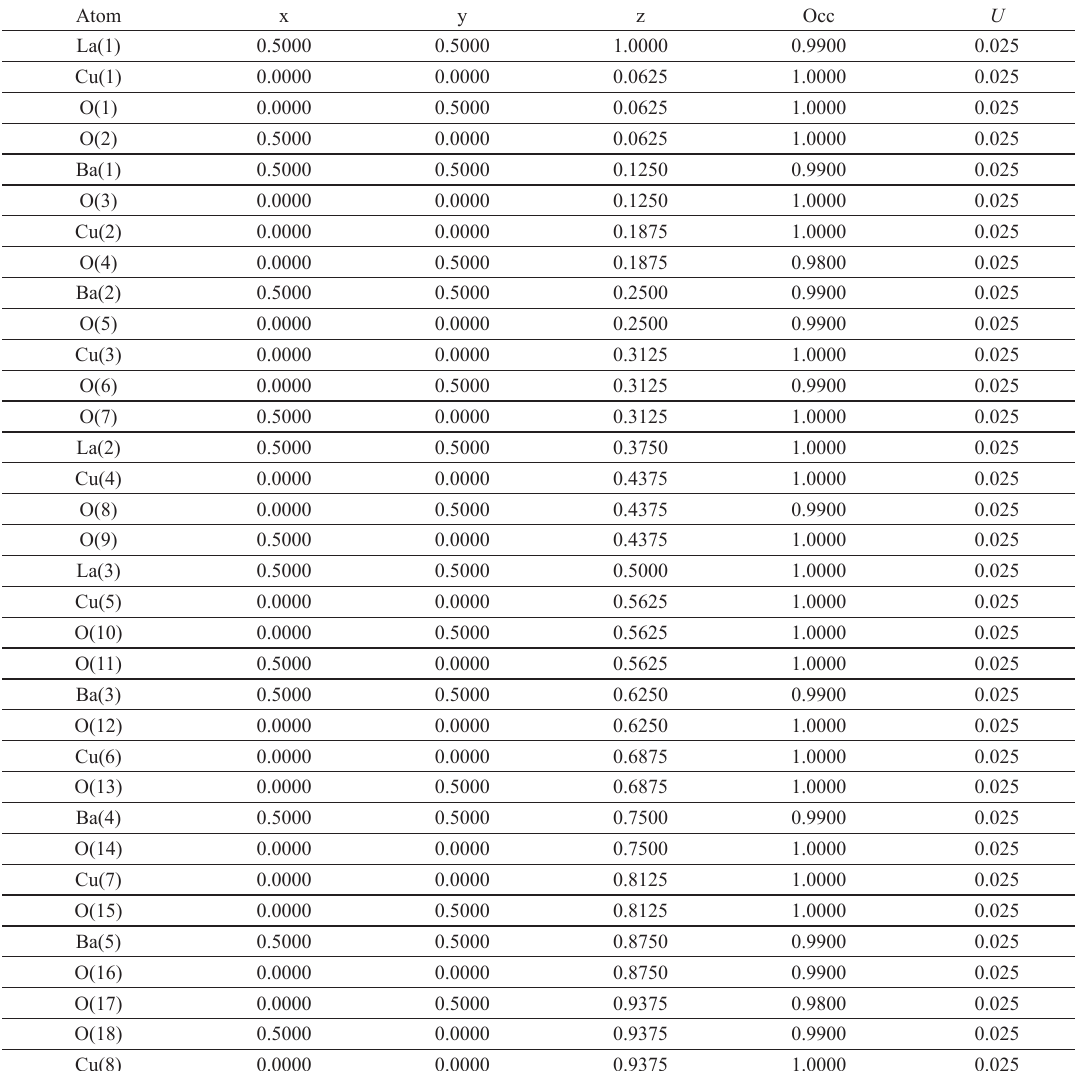
Ba Cu O sample. 3 5 8 18-δ